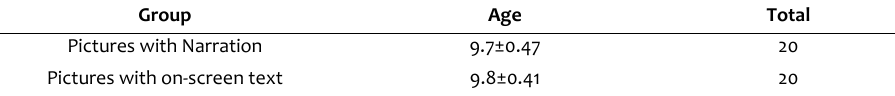
Table 1. Descriptive characteristics of participants examined as treatment condition and age. Group